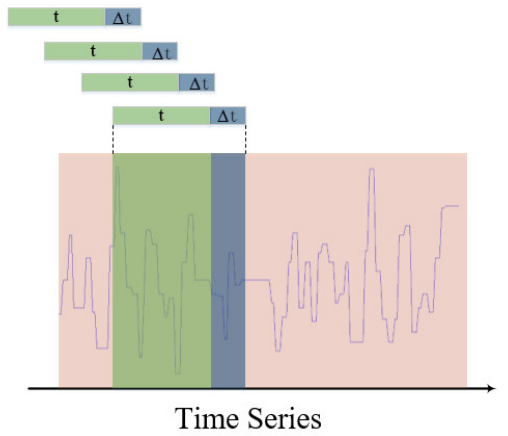
Figure 3. Fix–length slide window algorithm.